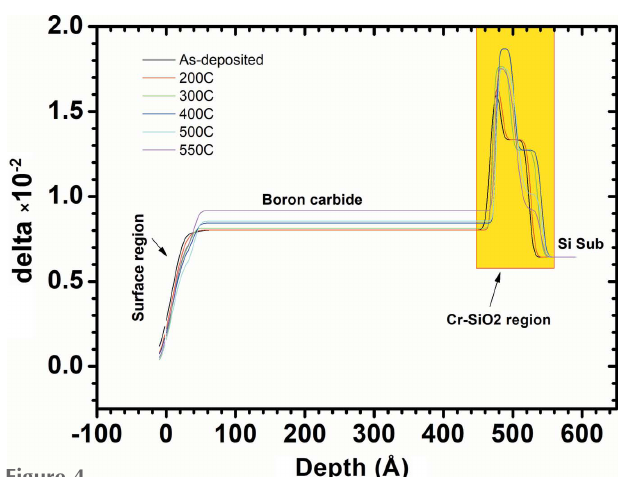
Figure 4 Optical density profile obtained from the best fit of SXR data taken after each annealing temperature. The region marked in the box is zoomed and shown in Fig. 6.